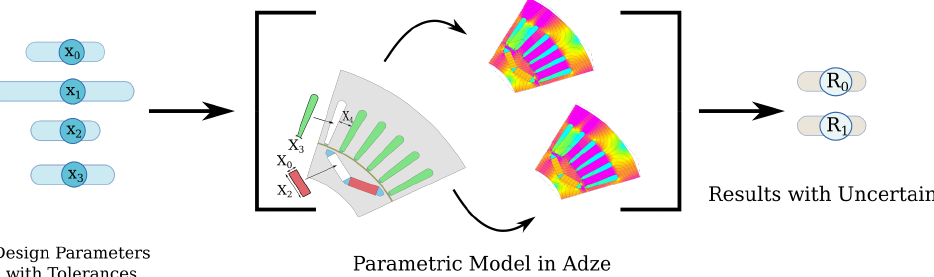
Figure 2. Automatic tolerance analysis with the enclosed parametric FEM in digital-twin-distiller ( R 0 , R 1 ).